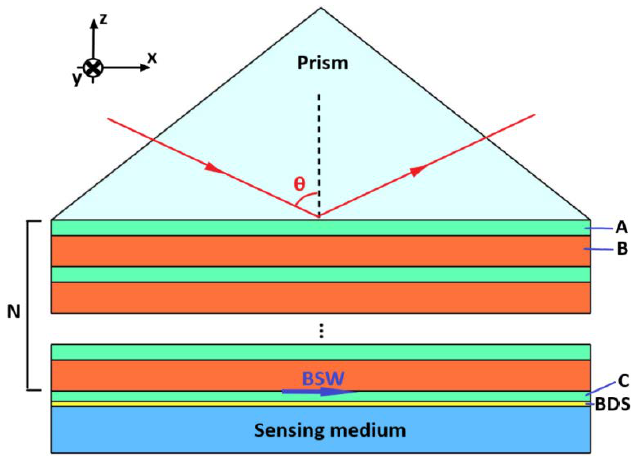
Figure 1. Schematic diagram of BSW sensor based on one-dimensional photonic crystals and BDS.